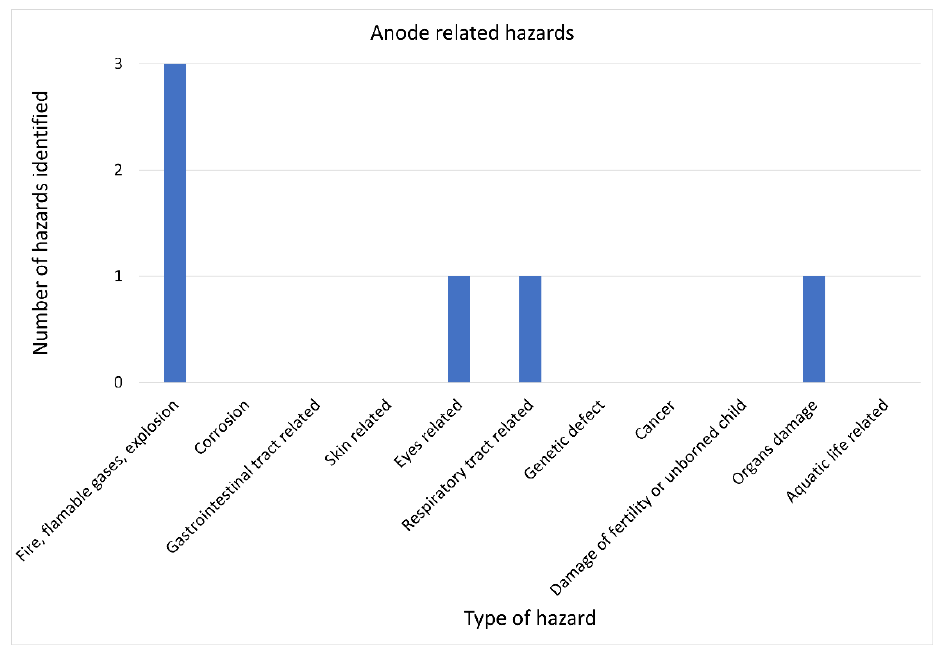
Figure 6. The number of the hazards identified versus type of hazard for anode materials in Mg–S cells.